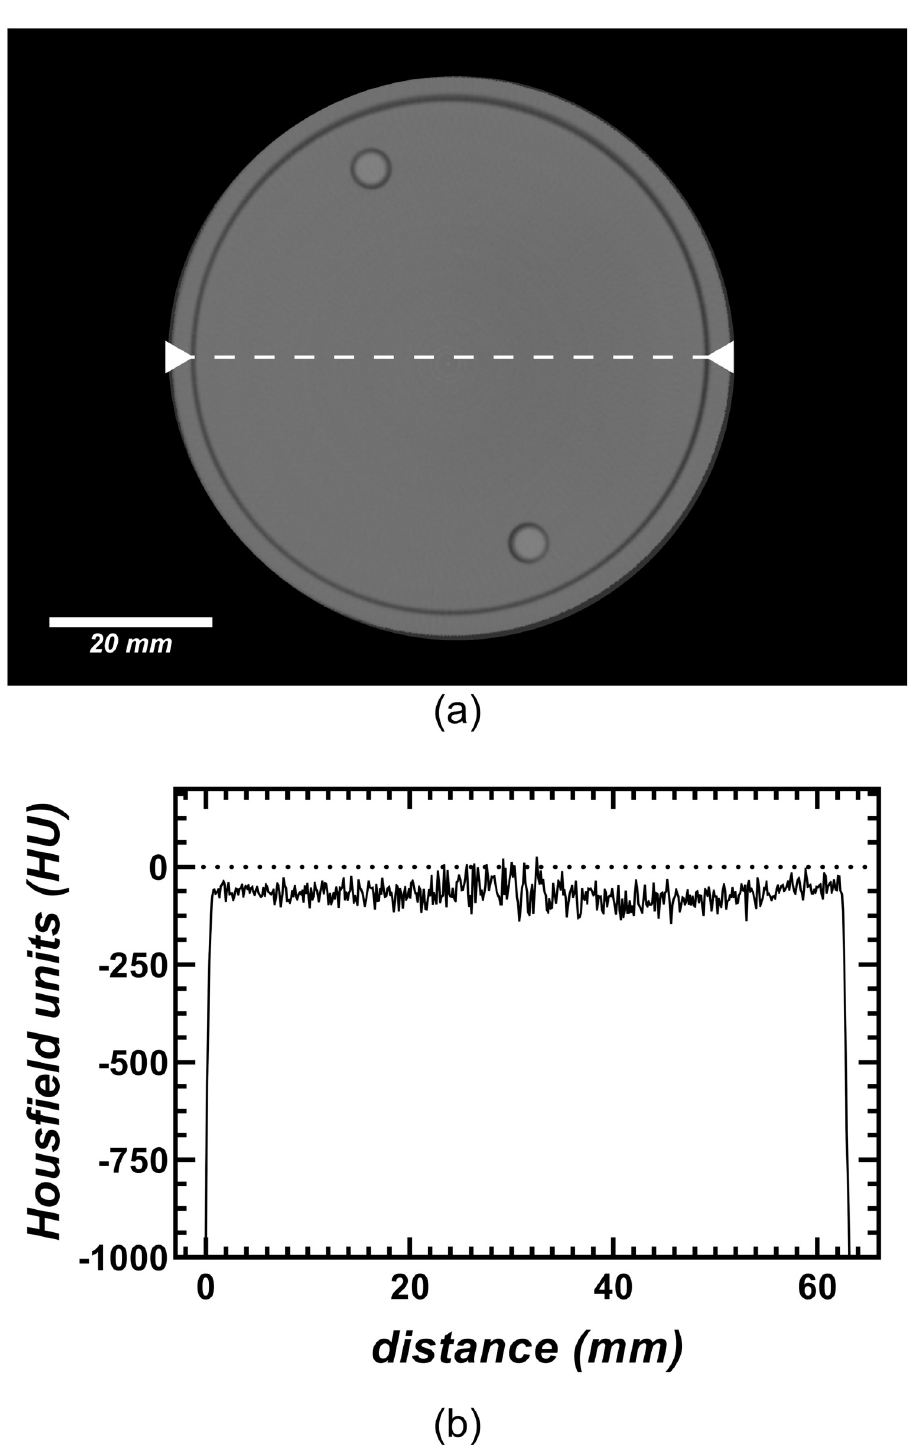
Fig 14. (a) Reconstructed transaxial-slice CT image of the uniformity plate of the CT quality assurance phantom. (b) Radial signal profile taken through the center of the uniformity plate as illustrated by the white dotted-line in (a).